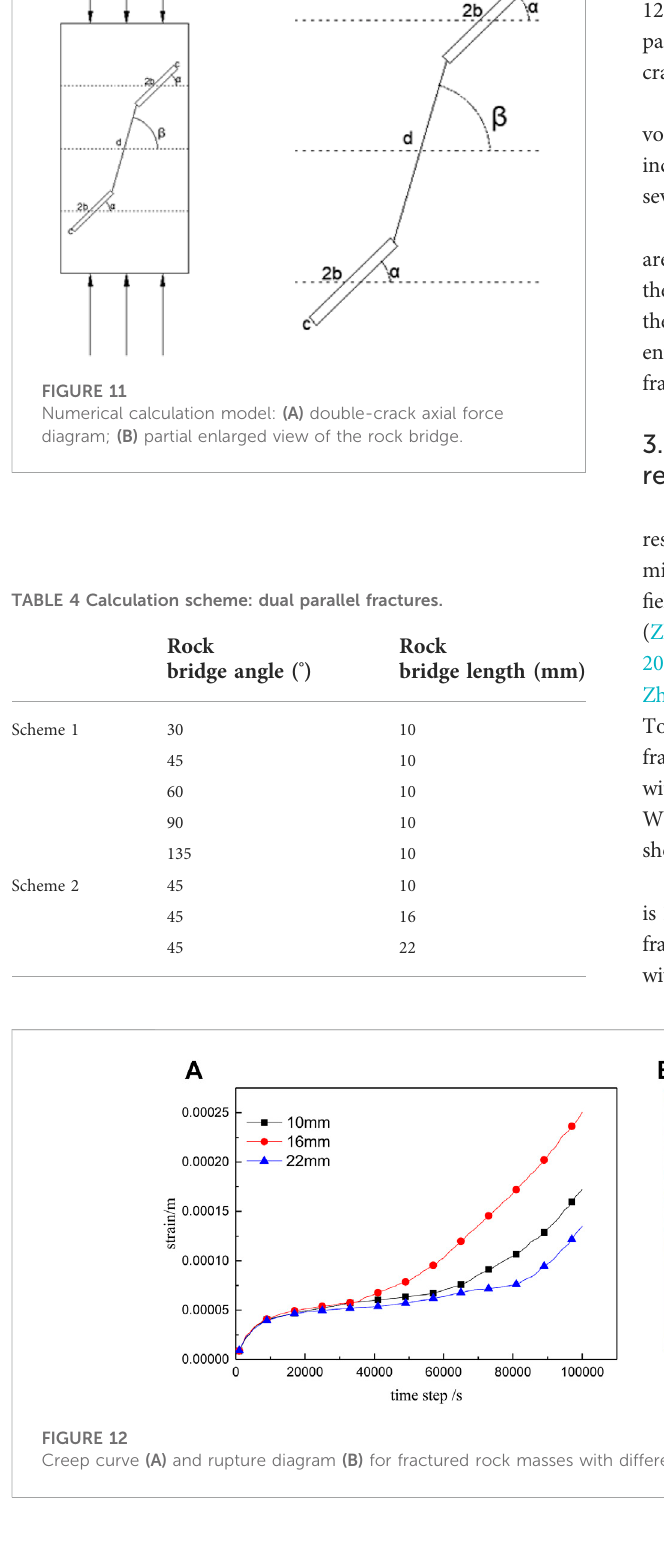
Frontiers in Earth